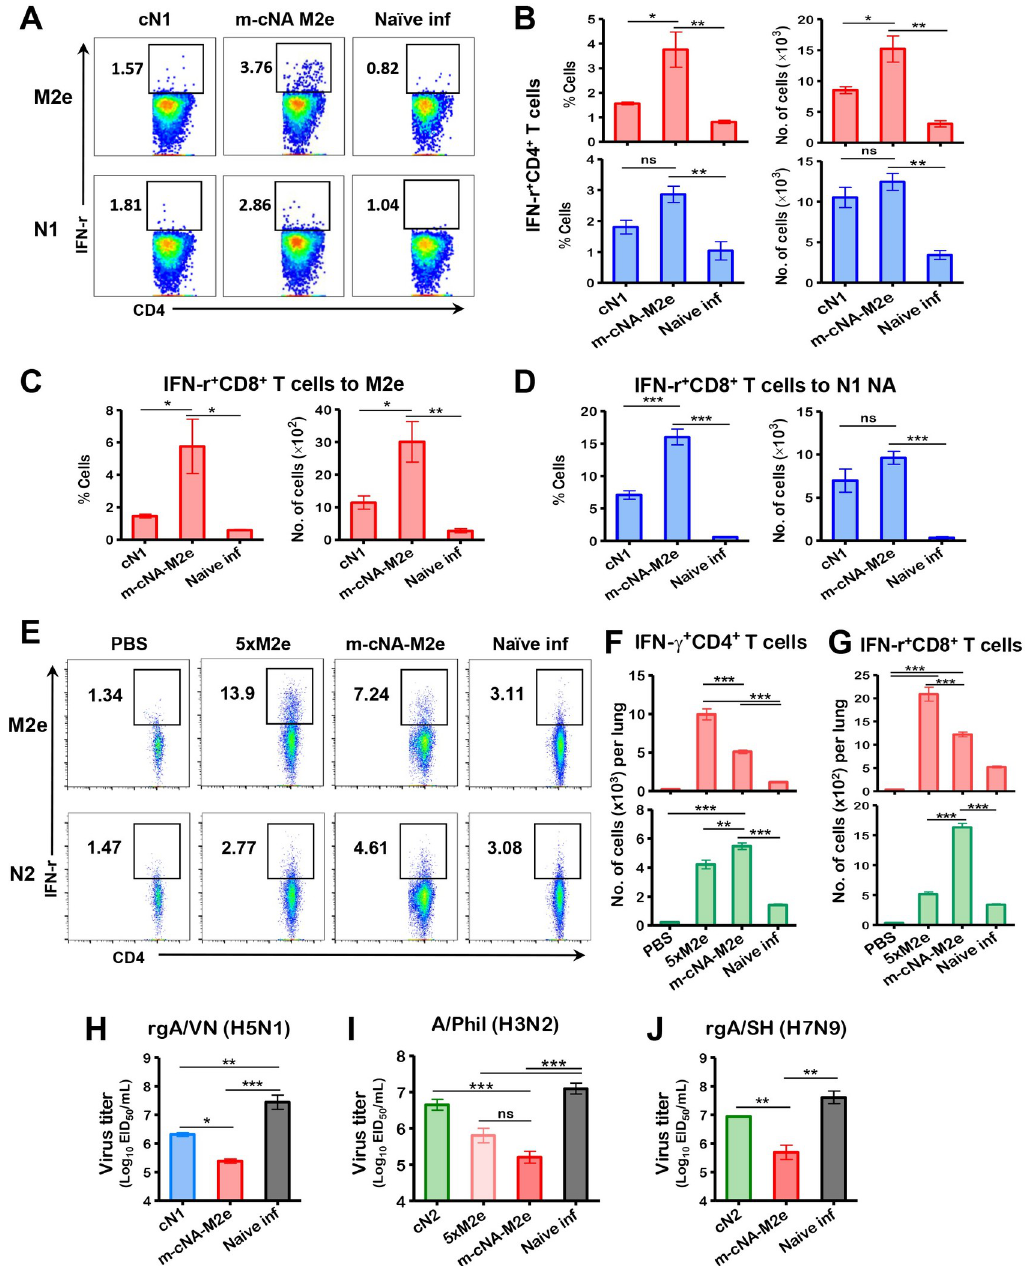
Fig 5. CD4+ and CD8+ T cells responses and diminished lung viral loads by m-cNA-M2e VLP vaccination after virus challenge. Immunized mice (n = 4 per group) were challenged with a lethal dose of (A-D) rgA/VN/2004 H5N1 (3xLD 50 , 2.6x10 4 EID 50 ) and (E-G) A/Phil/1982 (H3N2) virus (3xLD 50 , 2.3x10 2 EID 50 ). (A-G) Effector CD4 or CD8 T cells secreting IFN- γ were analyzed in lung cells harvested on day 6 post infection after in vitro stimulation with 5 μ g/mL of M2e, N1 NA (A/Vietnam/ 1203/2004 H5N1) or N2 (A/Brisbane/10/2007) NA pooled peptides. (A) Representative flow profiles of IFN- γ + CD4 + T cells gated in percentages. (B) IFN- γ + CD4 + T cells specific for M2e peptide (red bar) or N1 NA peptide pools (blue bar). (C and D) IFN- γ + CD8 + T cells to M2e or N1 NA peptide pools. At day 6 following A/Phil/1982 (H3N2) challenge, (E) representative flow profiles of IFN- γ + CD4 + T cells gated in percentages. (F) IFN- γ + CD4 + T cells specific for M2e (red bar) or N2 NA (A/Brisbane/ 10/2007) peptide pools (green bar). (G) IFN- γ + CD8 + T cells to M2e (red bar) or N2 NA (green bar) peptide pools. (H-J) Lung viral titers at day 6 post lethal dose infection with (H) rgA/VN/2004 H5N1, (I) A/Phil (H3N2), and (J) rgA/SH (H7N9) by an egg inoculation assay in 10-day embryonated chicken eggs. EID 50 : 50% egg infectious dose. The statistical significances were performed with one-way ANOVA with Tukey’s Multiple Comparison test and indicated as � , P < 0.05; �� , P < 0.01; ��� , P < 0.001; ns, no significant difference between two compared groups.